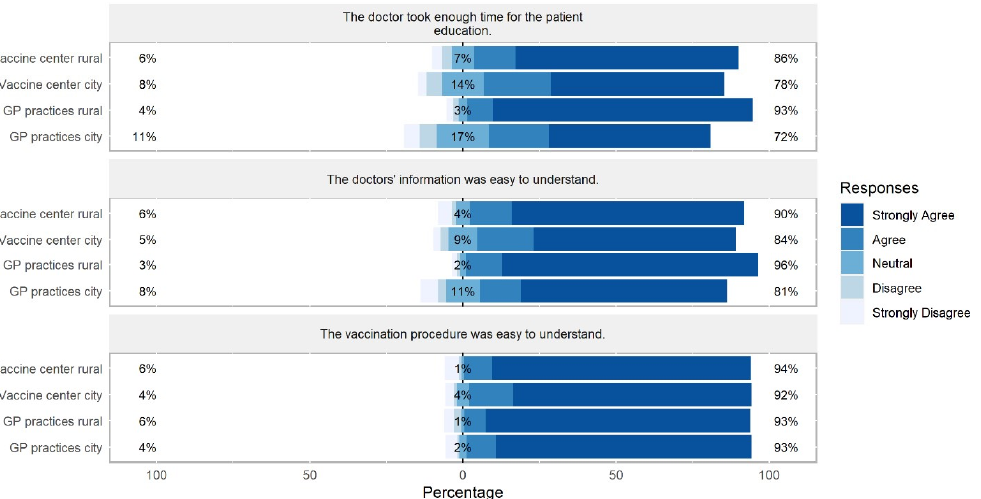
Figure 4. Differences between sites in participants’ perception of comprehensibility and duration sufficiency of the provided vaccination information. Percentages on the left and right side of the graph represent a summary of Strongly Agree and Agree on the right and Disagree and Strongly Disagree on the left side.